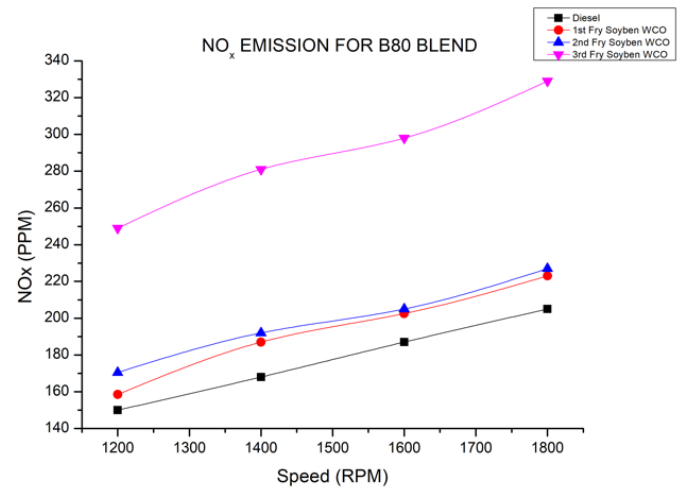
Figure 9. NO x emission of different fry oils (B80 blend) at different rpm.